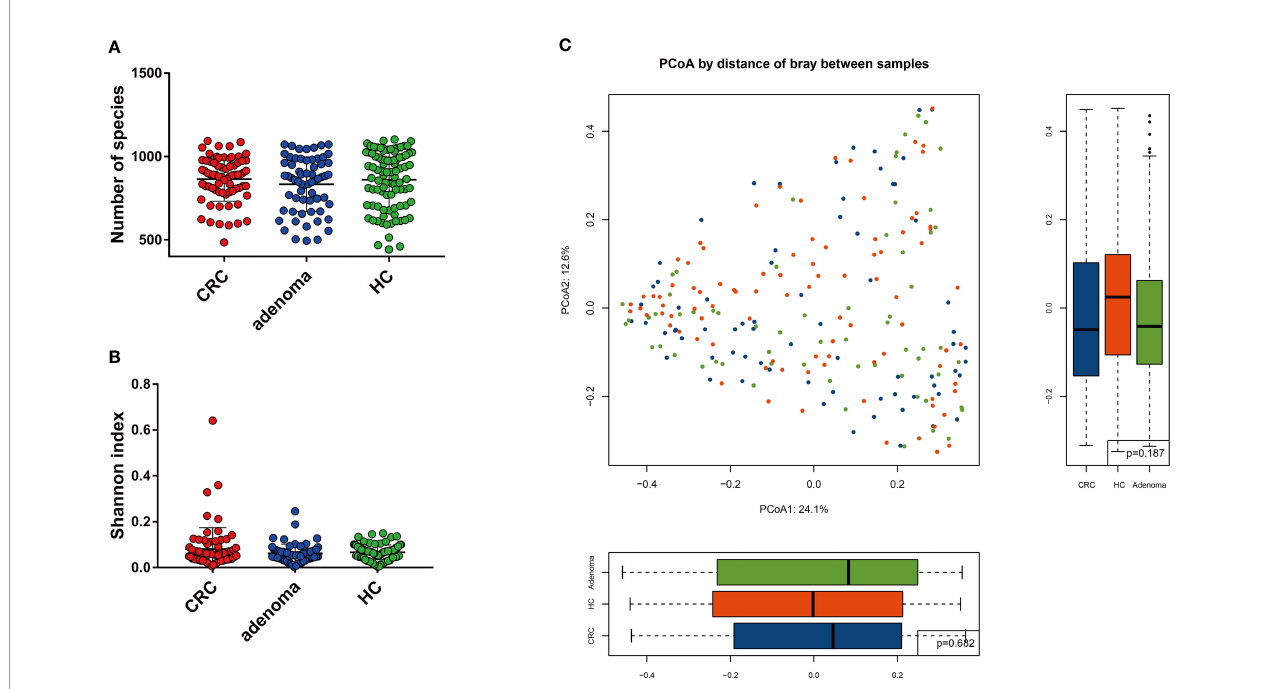
FIGURE 1 | The mycobiota diversity comparison between colorectal cancer (CRC), adenoma, and healthy controls (HC). The number of species (A) and Shannon index (B) were similar between the three groups. Principal coordinate analysis of the mycobiota in the three groups (C)